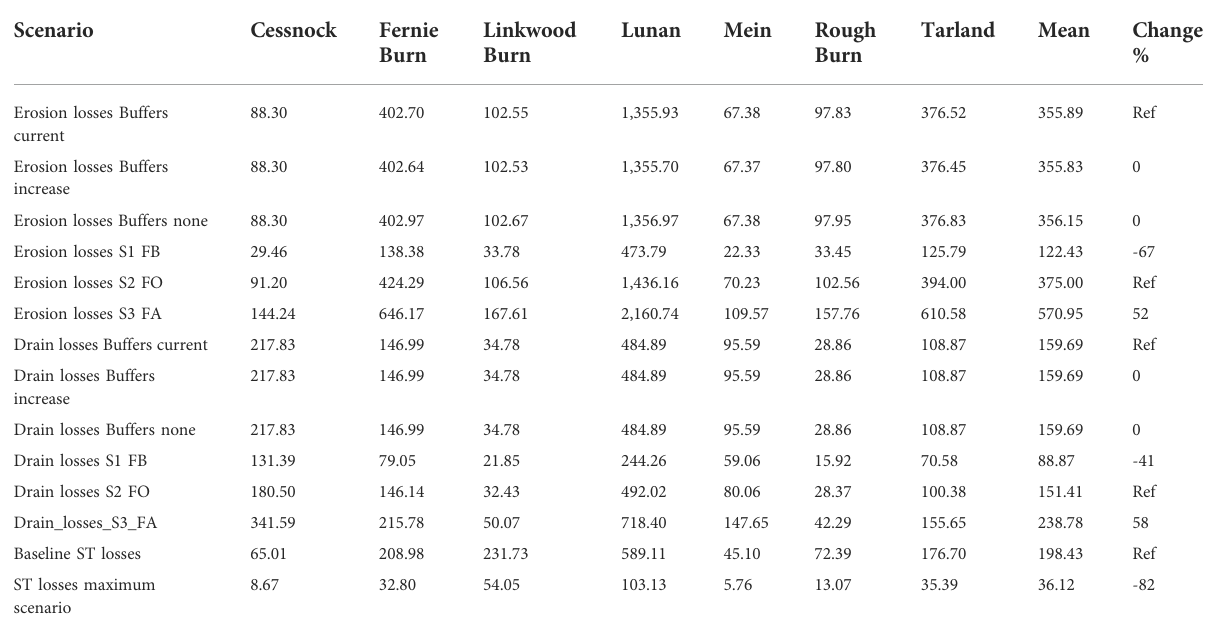
TABLE 3 Comparison of simulated total annual SRP loss kg yr − 1 per catchment under baseline and eight management scenarios in the spatial model. S1-S3 scenarios; FB – fertiliser application below agronomic optimum, FO – fertiliser application at agronomic optimum, FA – fertiliser application at agronomic optimum. Ref – reference used to calculate % change in SRP losses for different management